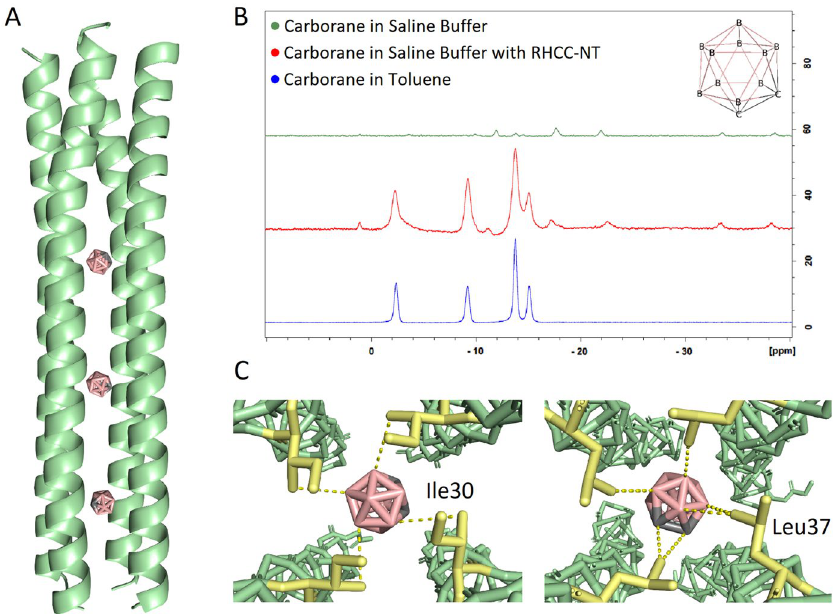
2 B 10 H 12 complex model at 2.2 Å (PDB ID 7R6H) which shows the uptake of three o -carborane molecules into the nanotube. ( B ) The uptake of o -carborane, C 2 B 10 H 12 was confirmed using Boron NMR showing Boron shifts from an aqueous into a hydrophobic environment. ( C ) Models of o -carborane in the center cavity’s hydrophobic environment. The hydrophobic boron cluster is coordinated between the amino acid side chains of Ile30 and Leu37 from each helix via van der Waals forces. Protein figures were made using PyMOL 2.3.2 (https:// pymol.